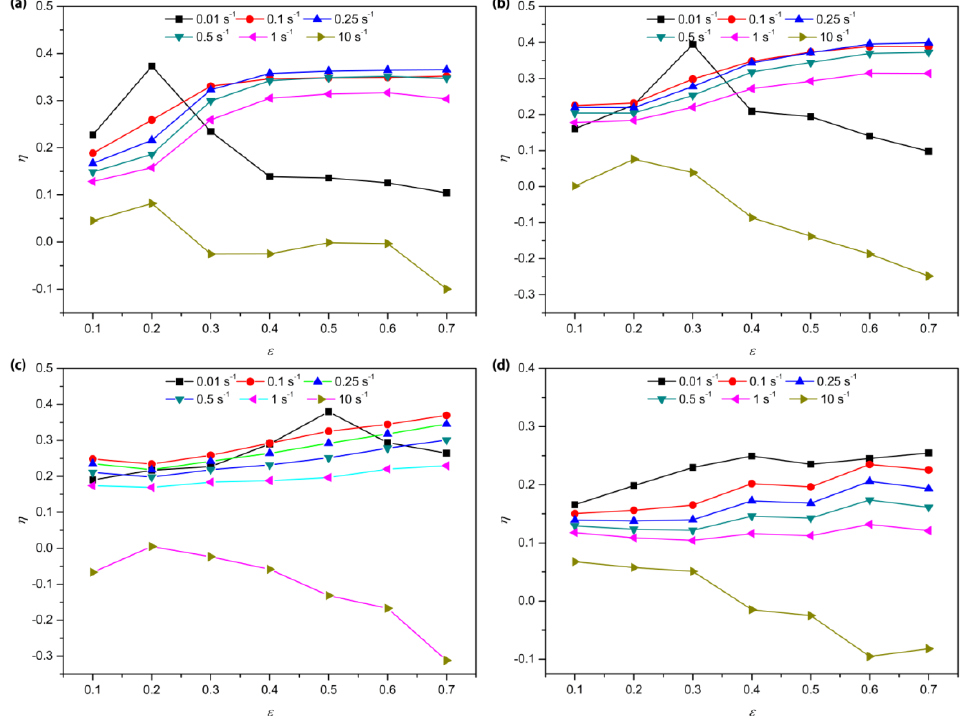
Figure 4. Effects of strain on the efficiency of power dissipation of the 30Cr2Ni4MoV steel at temperatures of ( a ) 1200 °C; ( b ) 1100 °C; ( c ) 1000 °C; and ( d ) 900 °C.